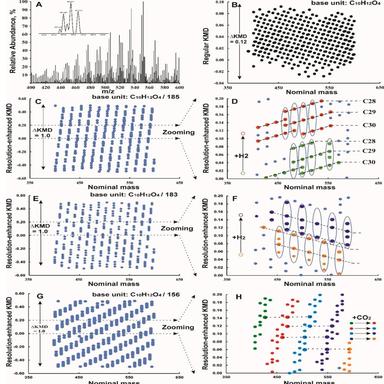
Fragment of the mass spectrum of juniper dioxane lignin in the range of m/z 400–600 (A) and its visualization in KMD (B) and REKMD (C-H) plots with X = 185 (C, D), 183 (E, F), and 156 (G, H).